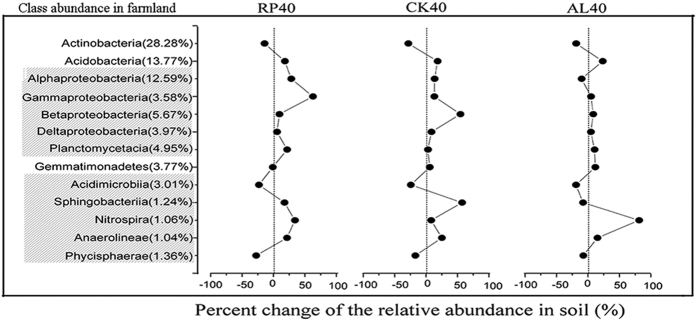
Distribution of 16S rRNA sequences across bacterial class communities following afforestation.